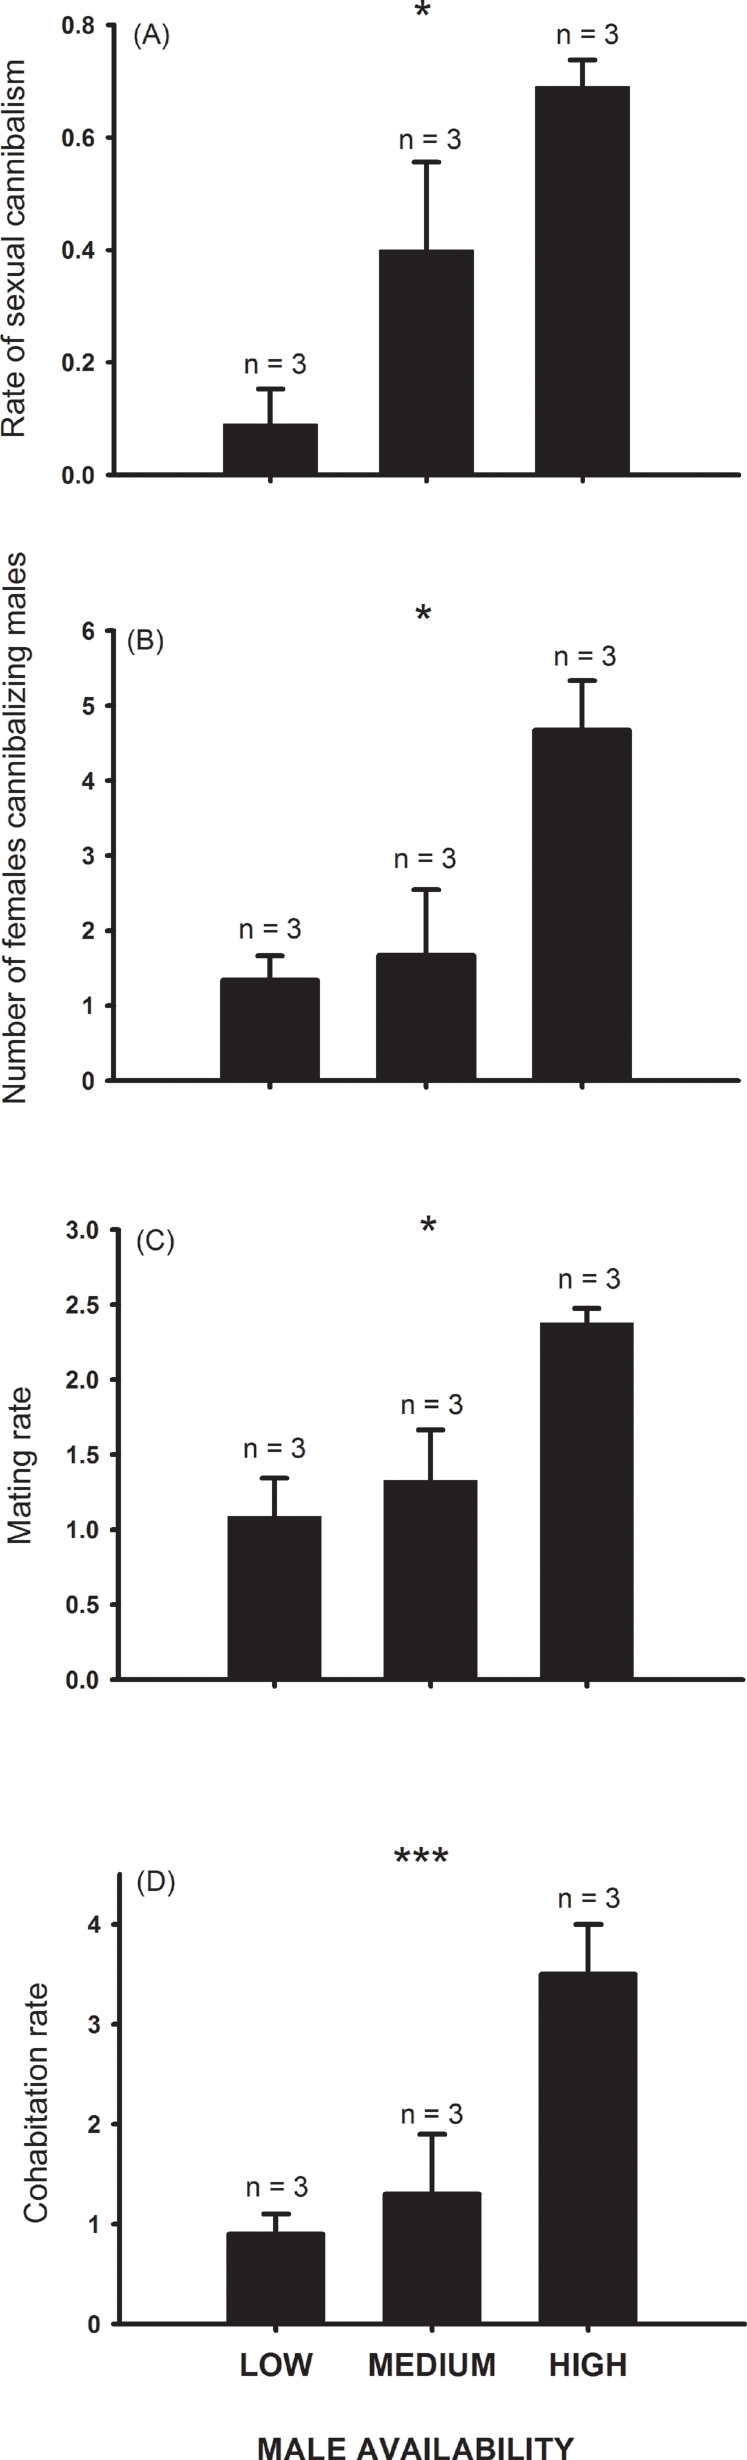
The effect of male availability on rates of sexual cannibalism, mating and cohabitation in female Lycosa tarantula.Solid bars and error bars represent means (calculated as the mean of the plot-level values of the response variables) and standard errors for the three male-density treatments, respectively. (A) Rate of sexual cannibalism–average number of cannibalistic events observed among females and averaged among plots (F
2, 6 = 8.7, P = 0.017); (B) Number of cannibalistic females per plot (F
2, 6 = 7.6, P = 0.02); (C) Mating rate–average number of copulations per plot (F
2, 6 = 7.6, P = 0.02); and (D) Cohabitation rate–average number of males observed within 20 cm of a female burrow within each plot (F
2, 6 = 25.8, P<0.001). Symbols denote significant differences among groups: *, P<0.05; *** P<0.001. More powerful tests for linear trends can be found in the text.